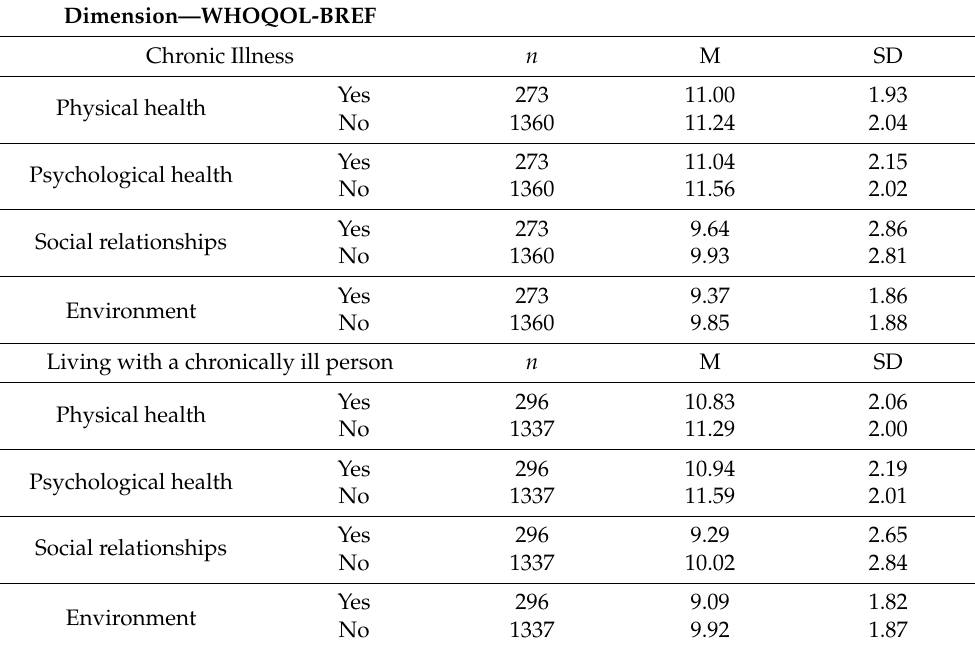
Table 3. Means and standard deviations in quality-of-life scores according to whether the participants have a chronic illness or are living with a chronically ill person.